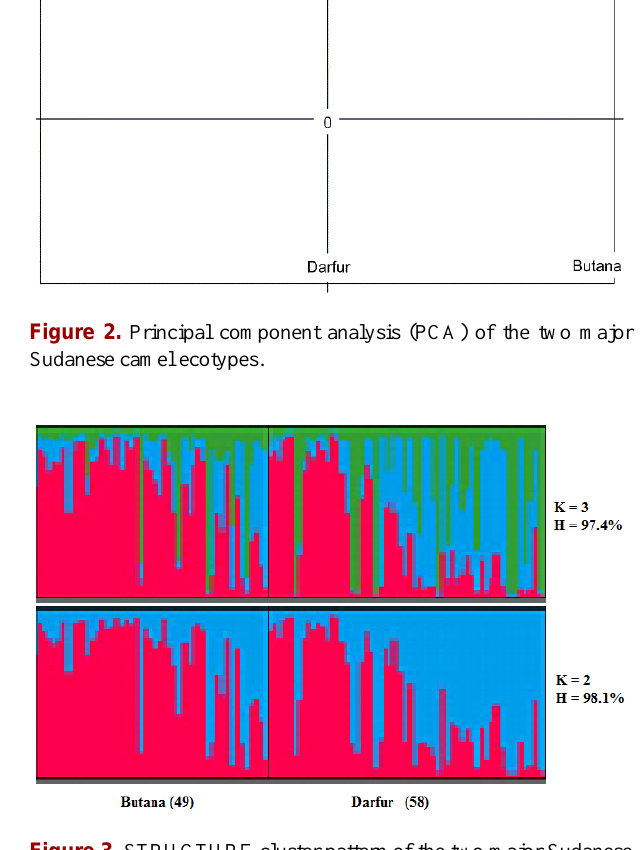
Figure 3. STRUCTURE cluster pattern of the two major Sudanese camel ecotypes, where K is number of clusters, H is the similarity index, and the numbers in brackets refer to sample